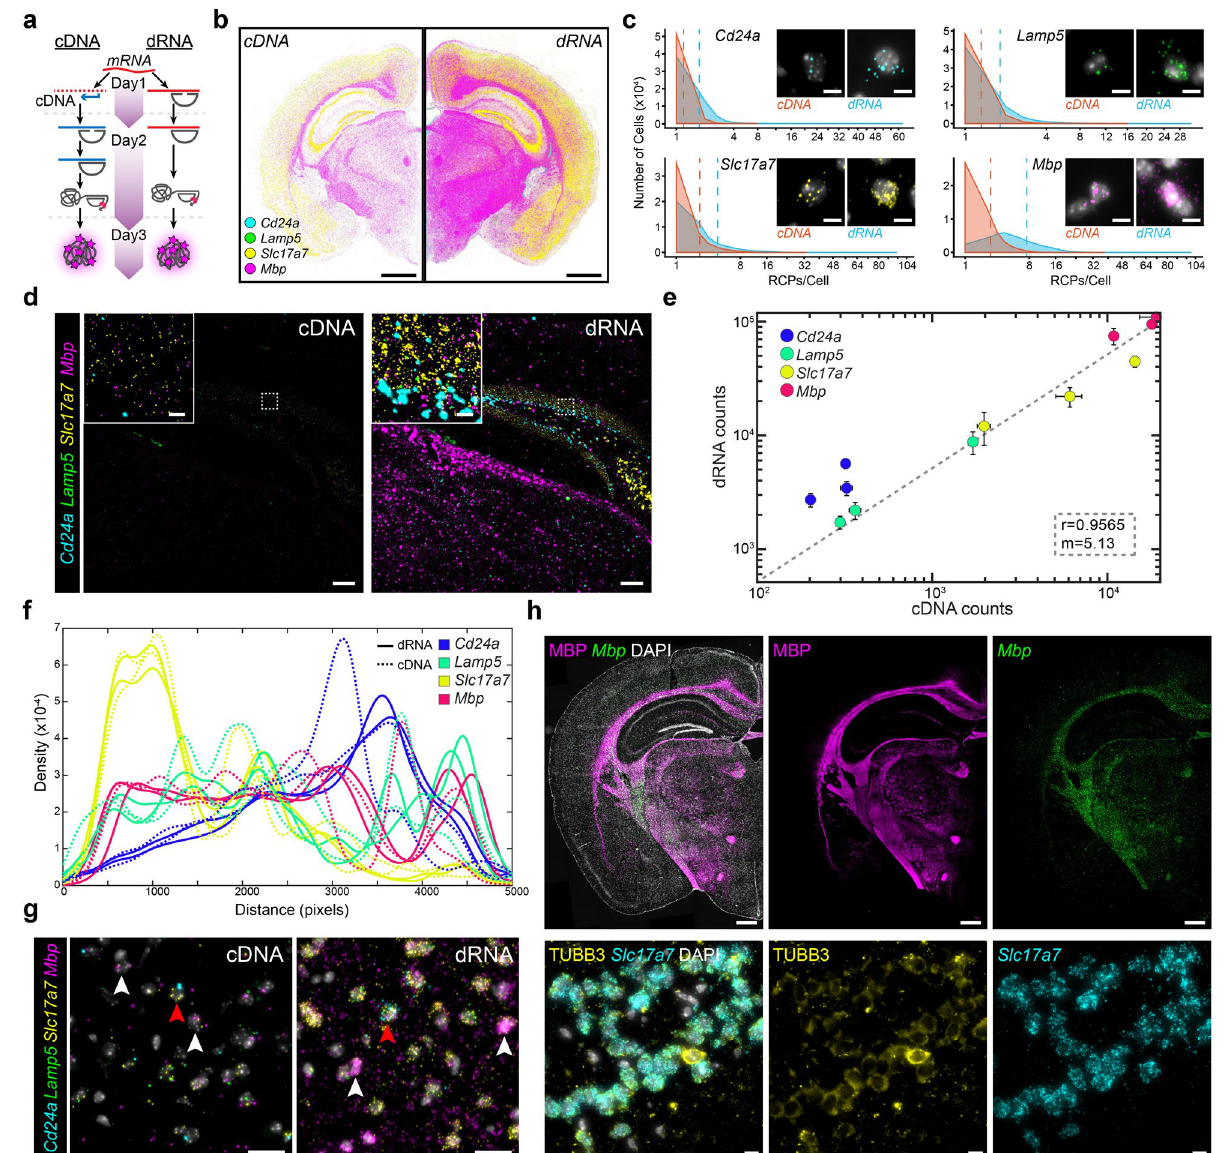
Figure 1. dRNA-HybISS targeting in situ using a 4-plex gene panel. ( a ) Schematic of benchmarking experiment to compare cDNA- and dRNA-based HybISS. ( b ) Expression distribution of 4-plex gene panel ( Cd24a / La mp5 / Slc17a7 / Mbp ) across sequential half coronal mouse brain section. Displayed as output from MATLAB analysis pipeline. Scale bar, 1 mm. ( c ) RCP counts per cell of half coronal section and their frequency for each gene in the 4-plex panel. Representative raw images of single cells. Dashed lines represent the mean RCPs/ Cell count for the respective chemistries. Scale bar, 5 µm. ( d ) Representative raw image of 4-plex from one of three ROIs (Supplementary Fig. 1e,f). Experiments run in parallel and same post processing intensity level adjustments. ROIs include regions of cortex, hippocampus, and lateral ventricle. Scale bar, 100 µm, inset 10 µm. e, Correlation plot of total RCP counts of dRNA against cDNA in three ROIs. X-axis represents cDNA and y-axis dRNA. Each spot of same color represents the 3 ROIs and deviation calculated from consecutive sections. ( f ) Spatial distribution of 4-plex genes across mouse cortex ROI between cDNA and dRNA. ( g ) Multiplexed distribution of 4-plex genes in cortical region. Cd24a + cells indicated by red arrowheads, Mbp + cells indicated by white arrowheads. Scale bar, 20 µm. ( h ) Colocalization of fluorescent immunohistochemistry with dRNA HybISS. Top panels show MBP protein detection with Mbp dRNA-HybISS. Bottom panels show pan-neuronal marker TUBB3 with excitatory neuron marker Slc17a7 . Scale bar, top 500 µm, bottom 10